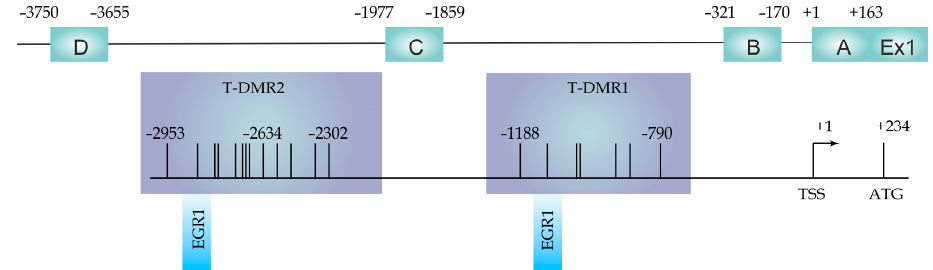
Figure 1. ESR1 promoters (A-D) and T-DMR1, and T-DMR2 regions localization with respect to transcription start site (TSS) and translation start codon (ATG). EGR1 indicates transcription factor binding sites. Adapted from [34].